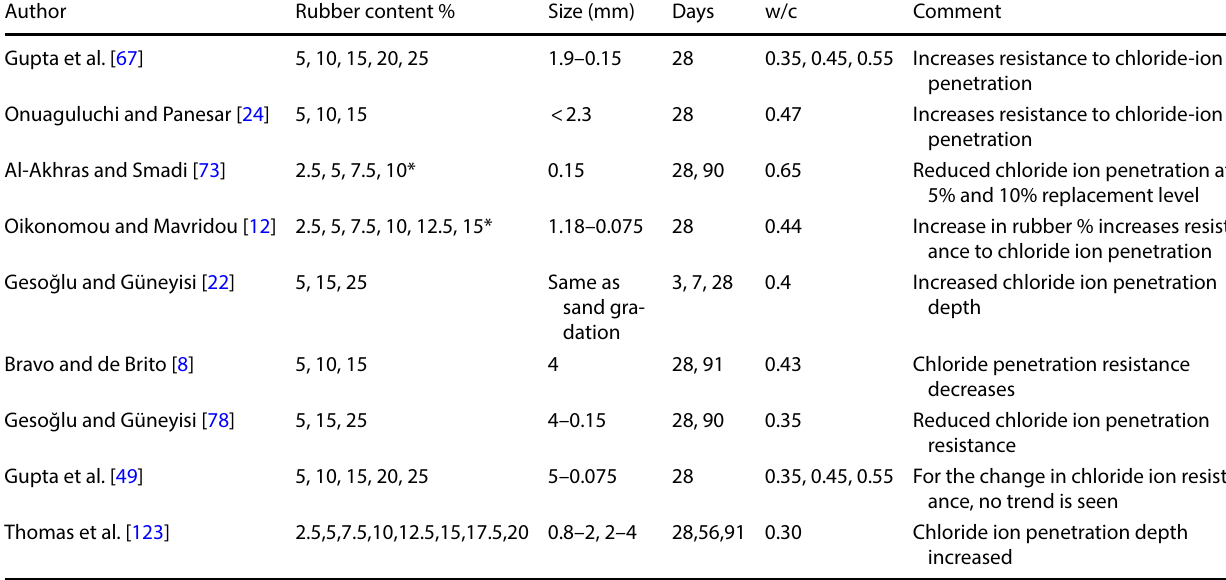
Table 7 Effect of waste recycled tire rubber on chloride penetration of